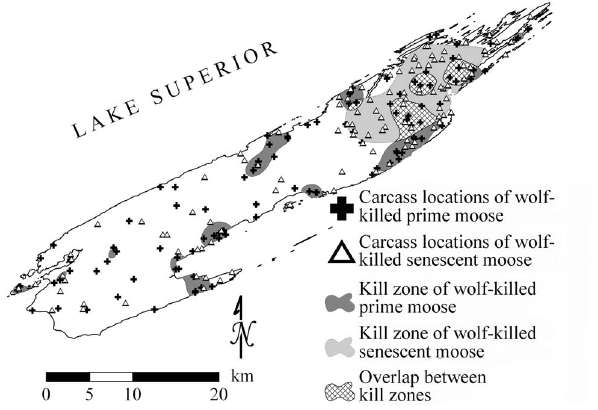
Figure 1. Carcass locations and kill zones, resulting from the core estimation of the kernel density estimates, for prime